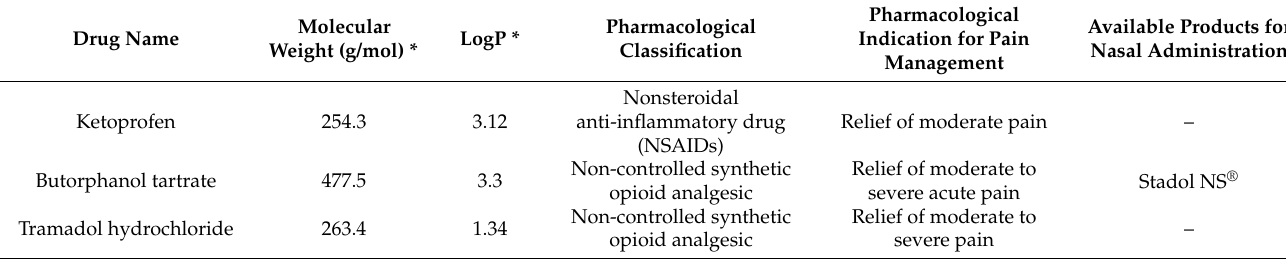
Table 1. Physicochemical and pharmacological properties of the investigated drugs for pain management. Drug